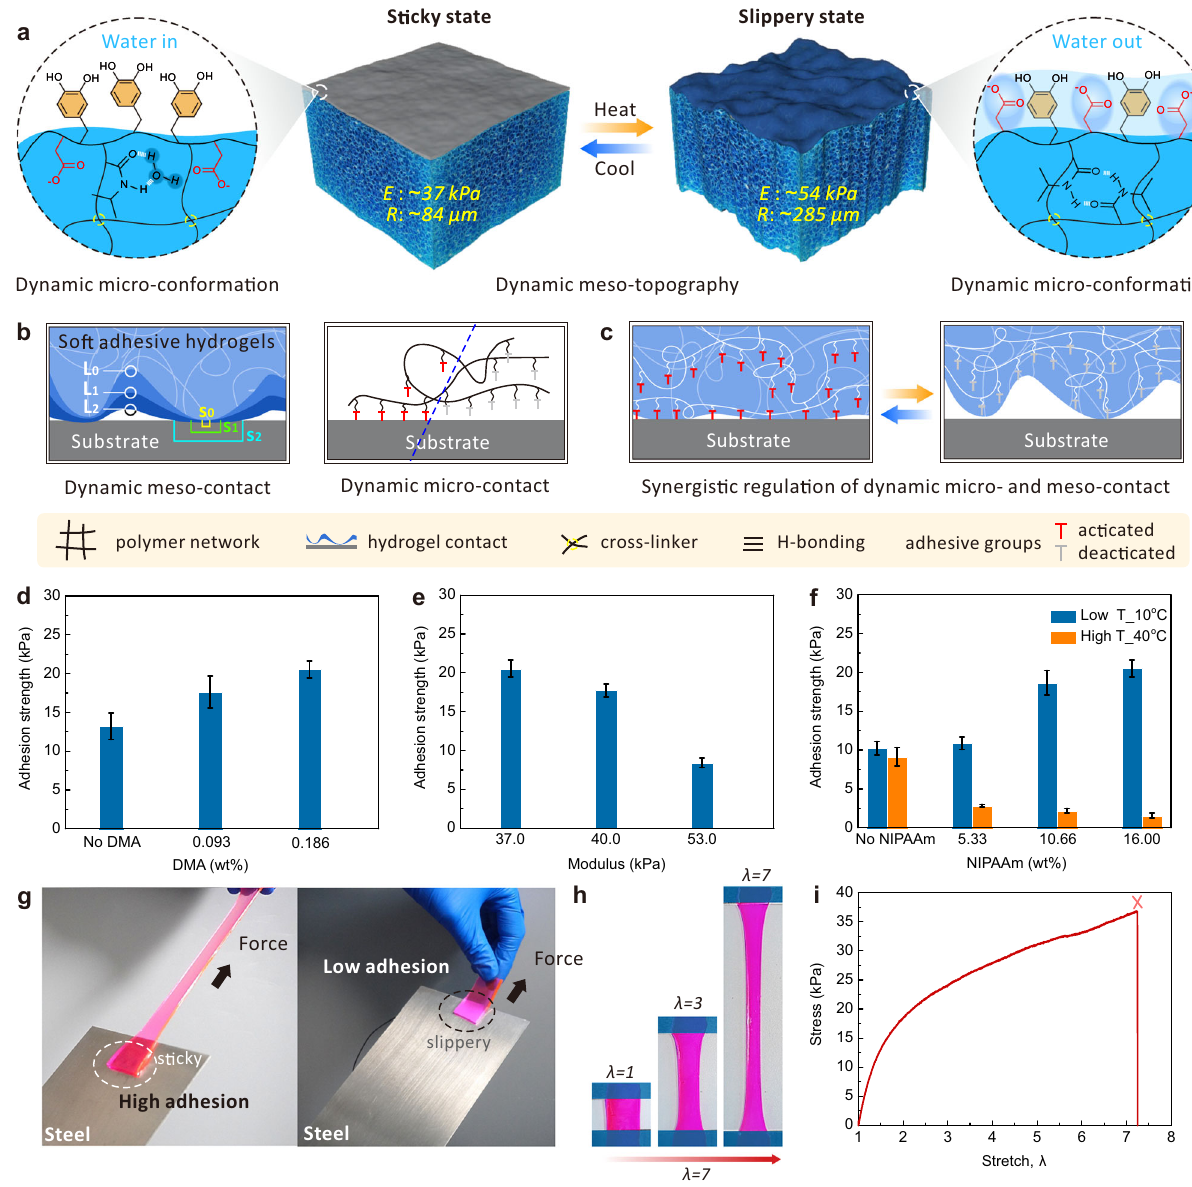
Fig. 1 | Design and realization of DMCS-hydrogel. a The sticky and slippery switching mechanism of DMCS-hydrogel via dynamic multiscale contact synergy originatingfromthedynamicmeso-topographyandmicro-conformation.E:elastic modulus, R: roughness. b Schematic diagram of meso-scale contact and micro- scale contact. Left, dynamic meso-contact via roughness and modulus change of soft adhesive materials. Right, dynamic micro-contact based on the activation and deactivation of adhesive groups. L 0 , L 1 , L 2 : distance between hydrogel surface and substrate; S 0 , S 1 , S 2 : contact area between hydrogel surface and substrate. c The